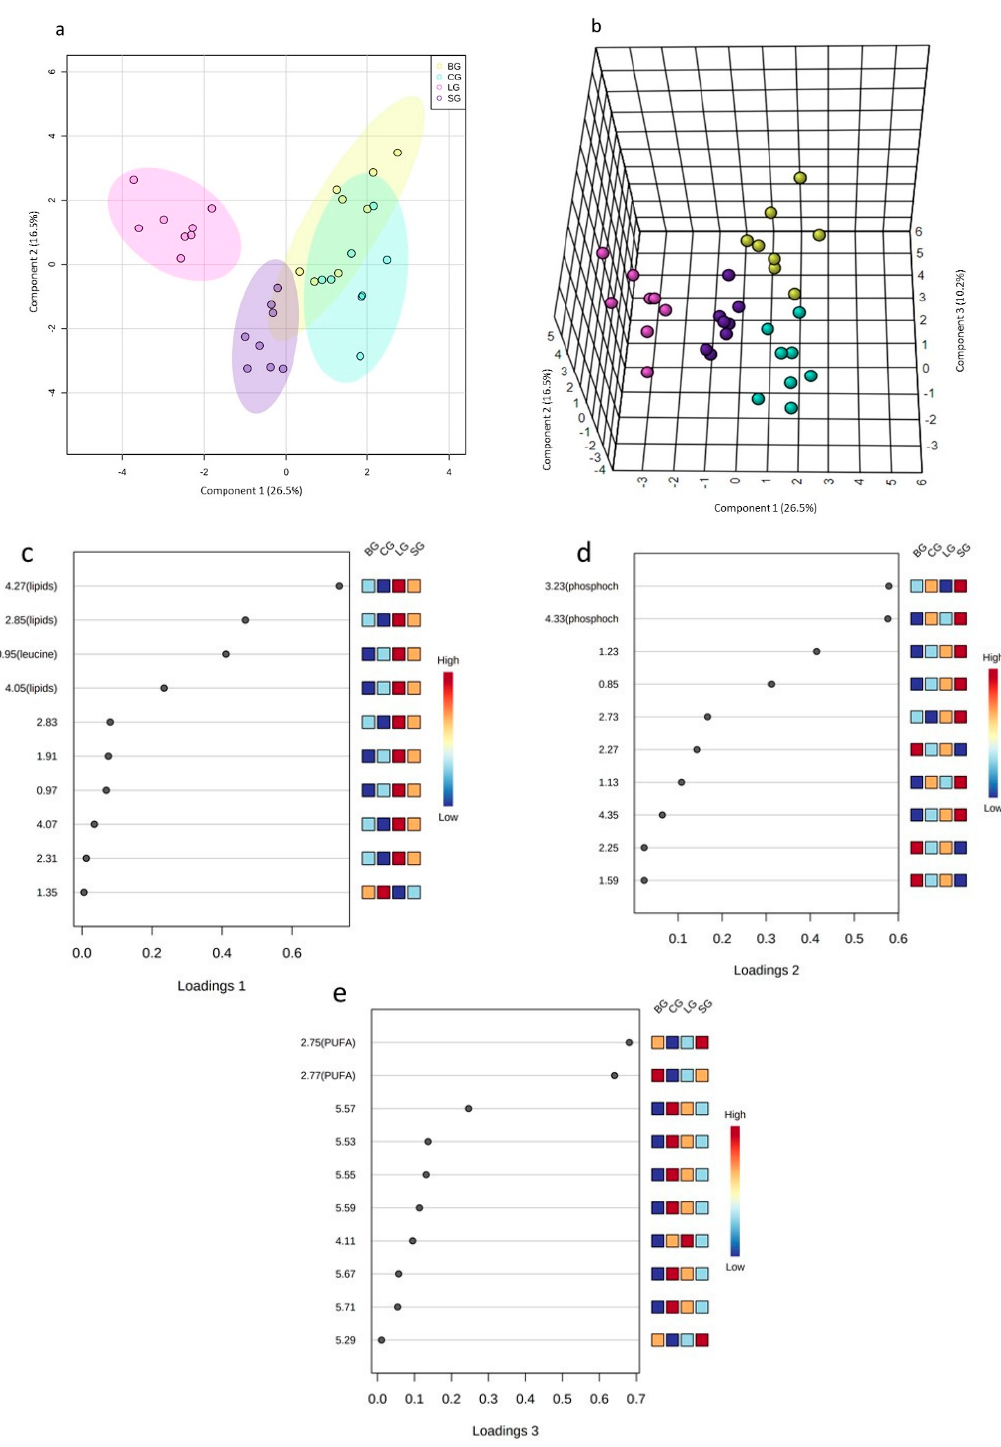
Figure 2. The 2D ( a ) and 2D ( b ) sPLS-DA score plots and loadings for components 2 ( c – e ) obtained from the 1 H NMR spectra (NOESYGPPR1D) of the serum samples from Swiss mice fed diets based on baru, coconut, linseed, and soybean oils. Legend: baru (BG), coconut (CG), linseed (LG), and soybean oil (SG) groups.